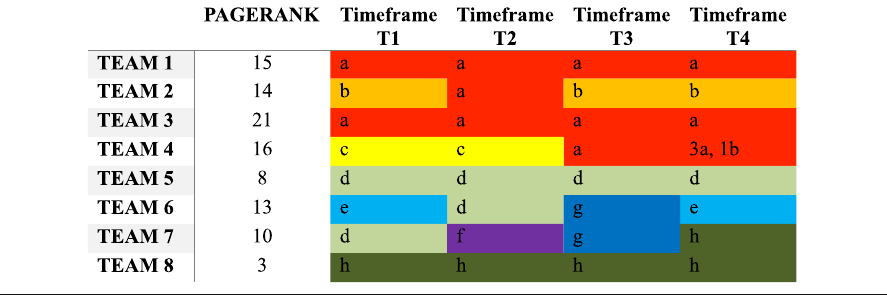
Table 1 Tabular representation of the communities arising from collaborations among teams